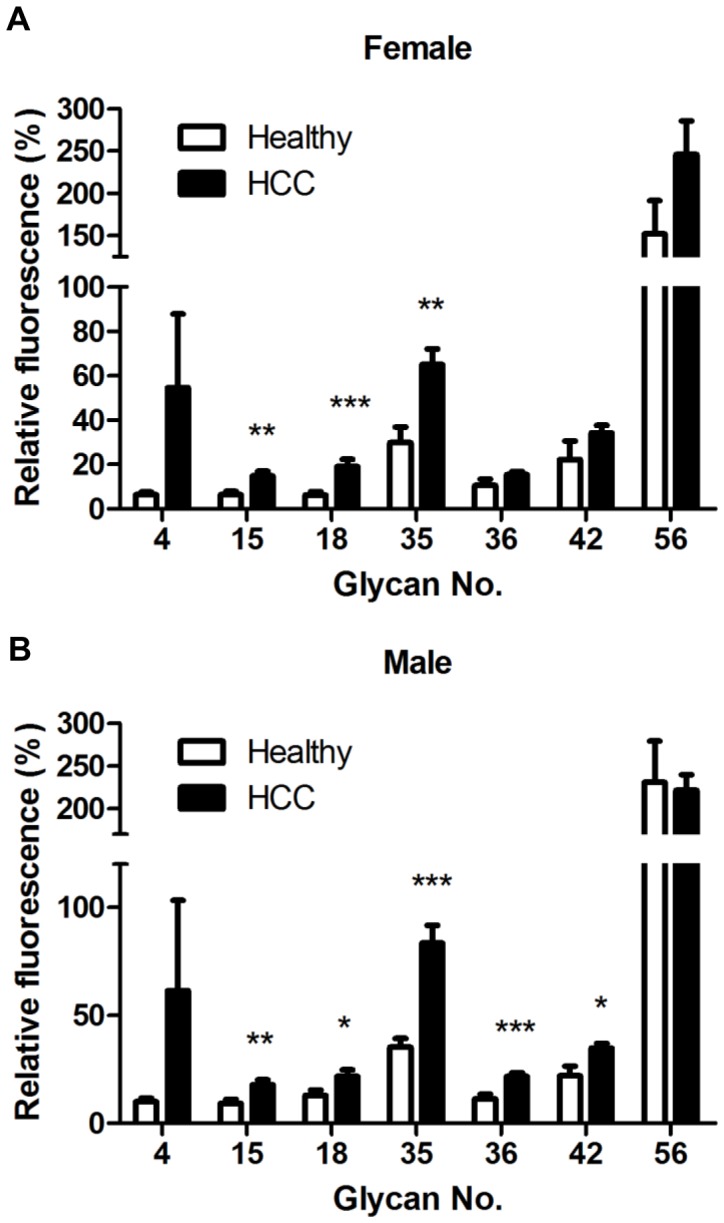
Comparison of the level of seven anti-glycan antibodies in serum from healthy individuals and patients with HCC for females and males.Relative fluorescence ratios were calculated as the fluorescence intensity for each glycan analog divided by the fluorescence intensity for Gb5, and they are expressed as percentages in the figures. The figure shows the mean ratio ± standard deviation for each glycan. (A) The glycan:Gb5 IgG ratios for glycan numbers 15, 18, and 35 were significantly higher in serum from female patients with HCC (n = 70) than in serum from healthy females (n = 11). (B) The glycan:Gb5 IgG ratios for glycan numbers 15, 18, 35, 36 and 42 were significantly higher in serum from male patients with HCC (n = 223) than in serum from healthy males (n = 22). Asterisks indicate glycans in which the mean glycan:Gb5 IgG ratio was significantly higher in serum from patients with HCC than in serum from healthy individuals. The p values were calculated with a Student’s t-test (*P<0.01).